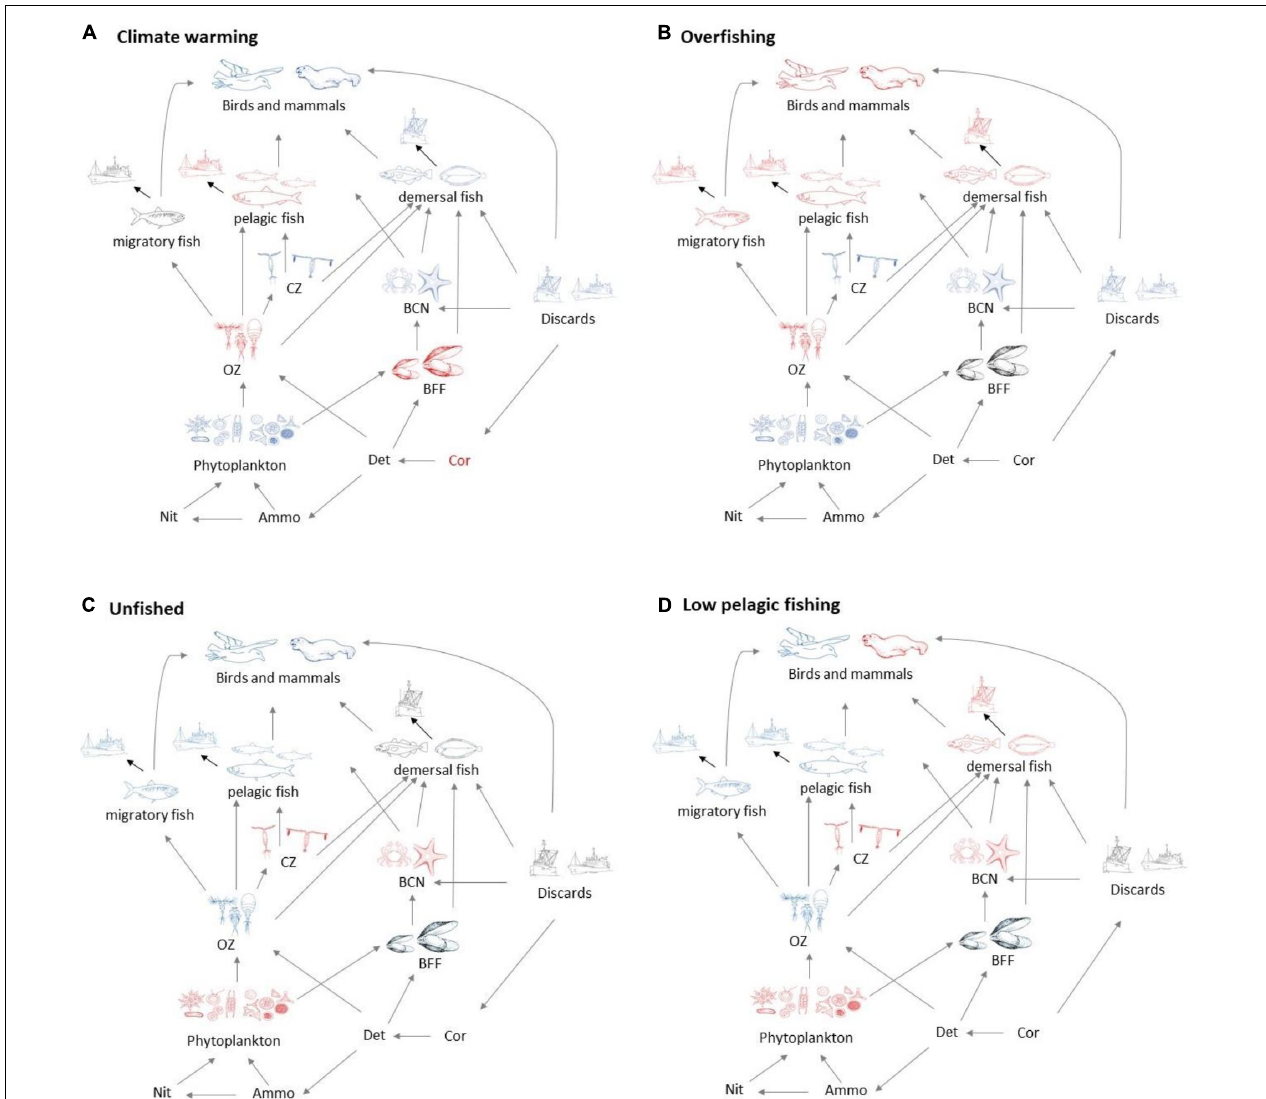
FIGURE 3 | Schematic showing broad foodweb impacts of (A) warming and (B) overfishing compared with (C) the unfished state without warming and (D) states with low pelagic but high demersal fishing. All states are shown relative to recent history (no warming, medium levels of demersal, and pelagic fishing). Blue groups have increased biomass, and red groups reduced biomass, whilst grey indicates little change, except for discards in the unfished scenarios, which are